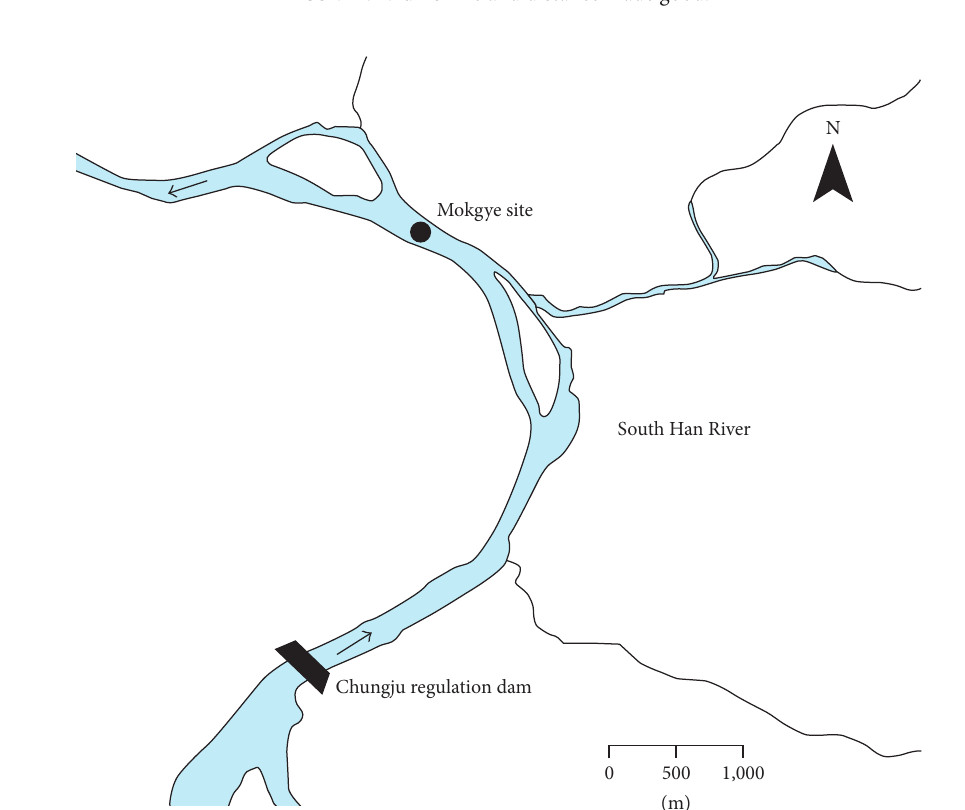
Figure 2: Rhumb line and distance made good.